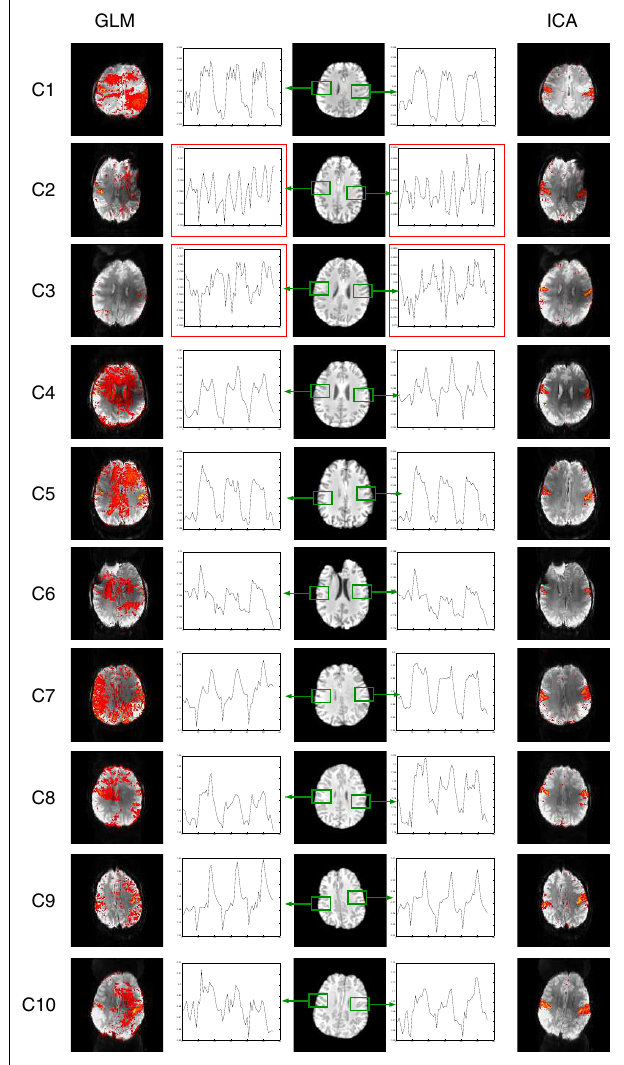
FIGURE 6 | Mean responses in voxels in primary motor areas in the chin task .Time courses in PMA in C2 and C3 (outlined in red) are non-model-conform, and correspond with low sensitivity in GLM results (left) but not ICA (right).